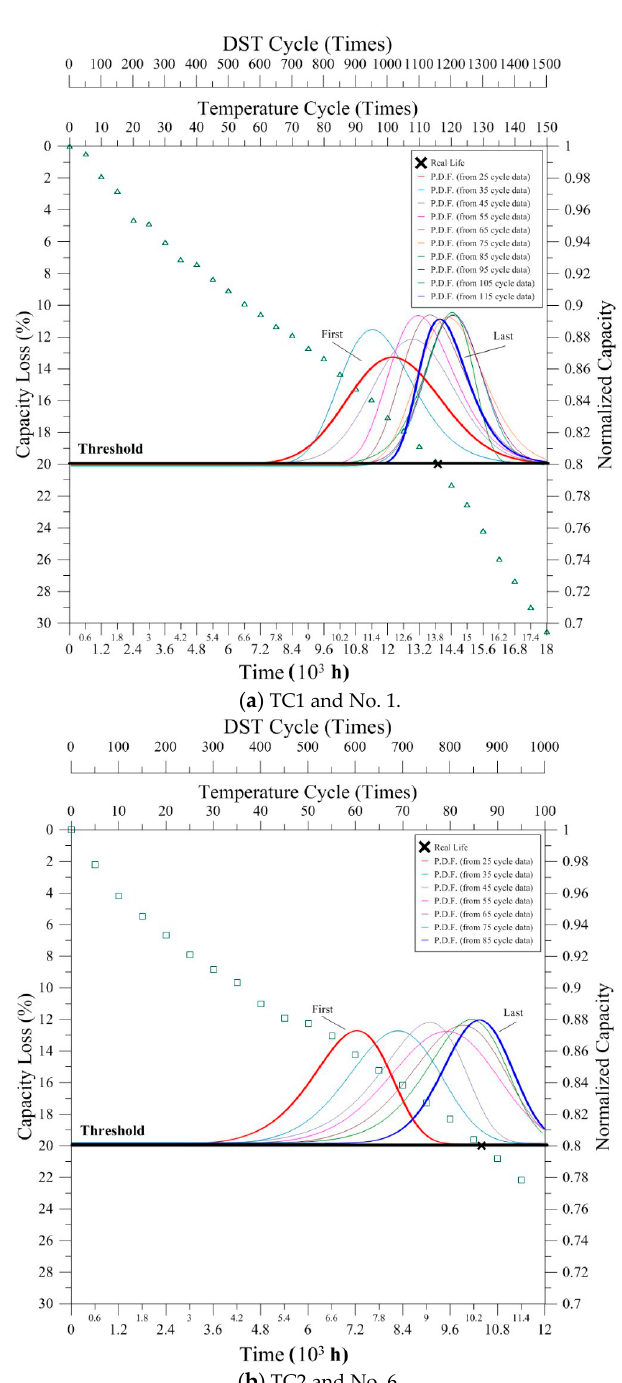
Figure 9. Lifetime prognosis of two test batteries in different temperature cycles.